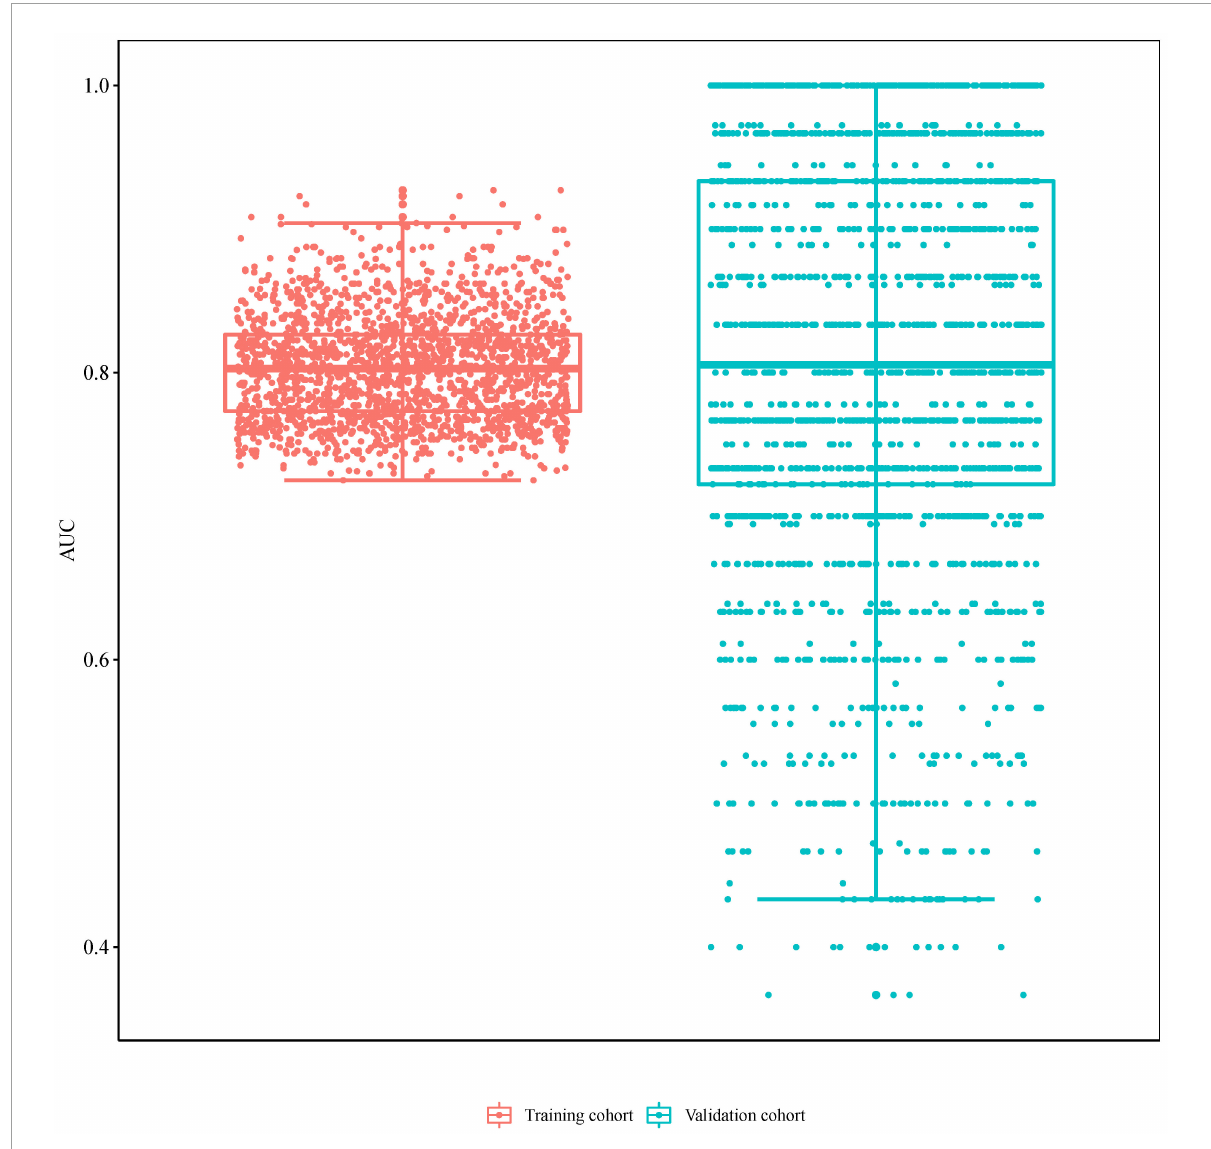
FIGURE4 The area under the receiver operating characteristic curve (AUC) value of 200 times stratified five-fold cross-validation in the training and validation